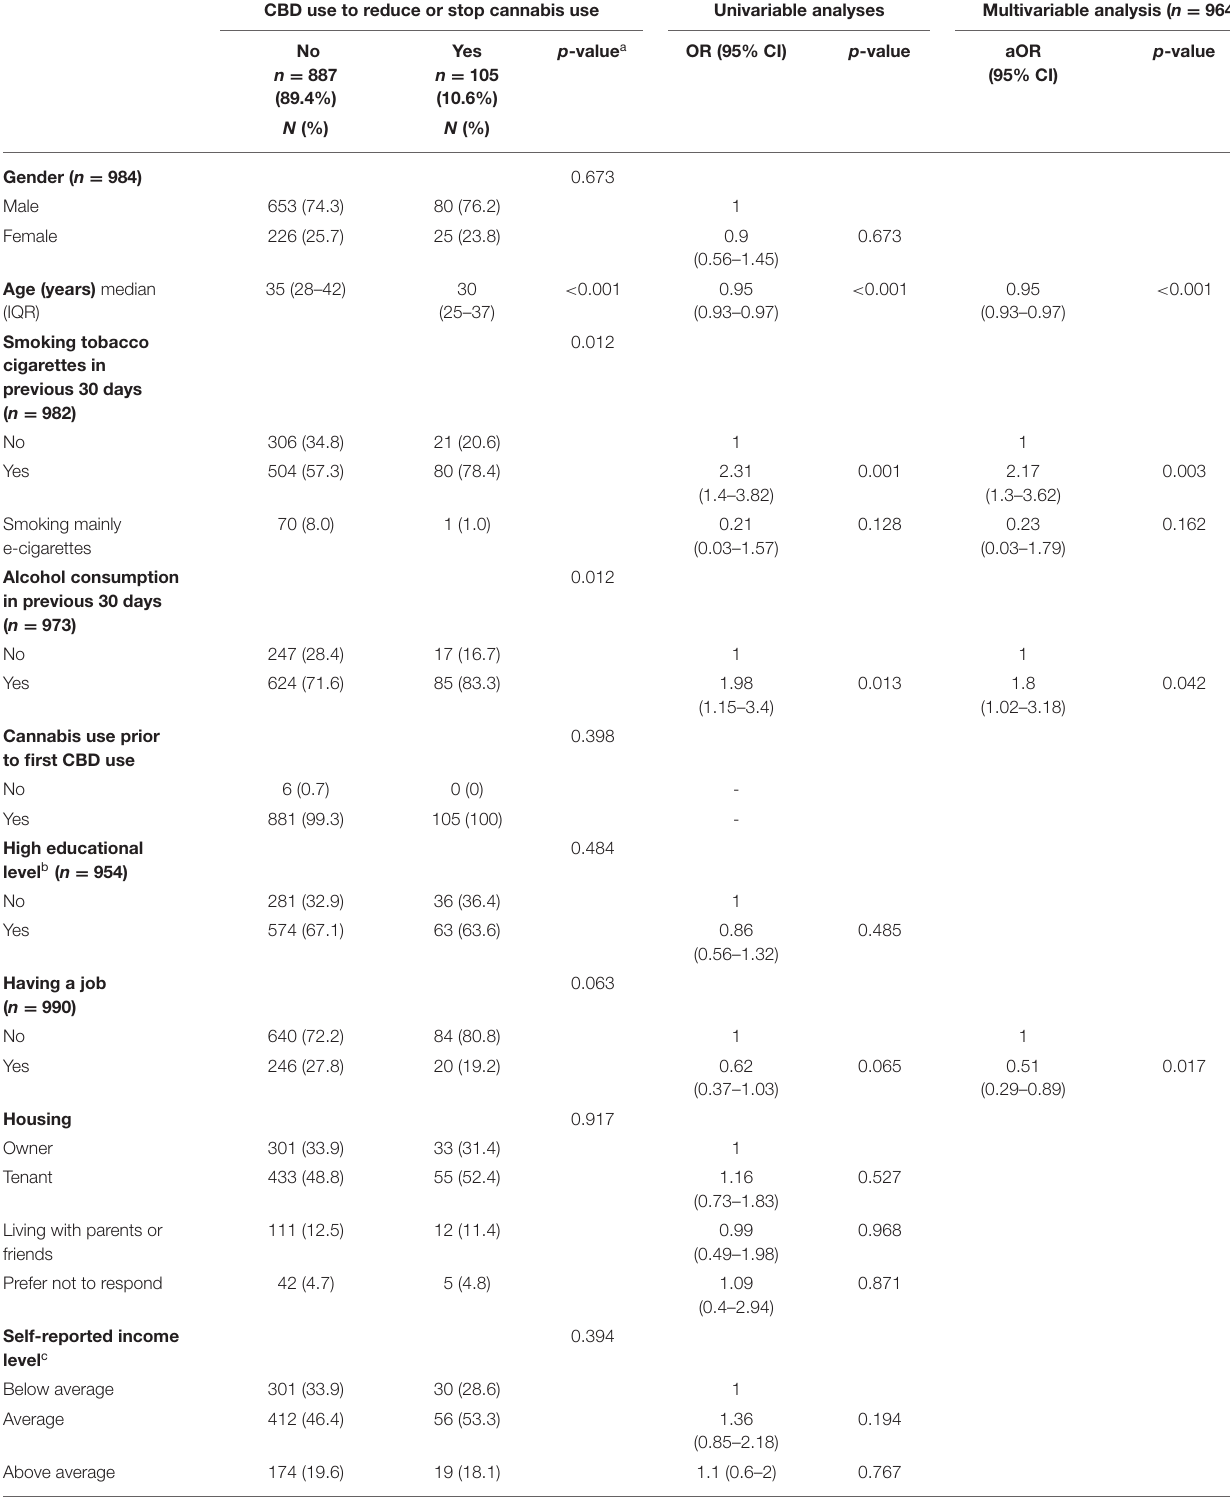
TABLE 1 | Study sample socio-demographic and behavioral characteristics and factors associated with the use of cannabidiol to reduce cannabis consumption (logistic regression). CBD use to reduce or stop cannabis